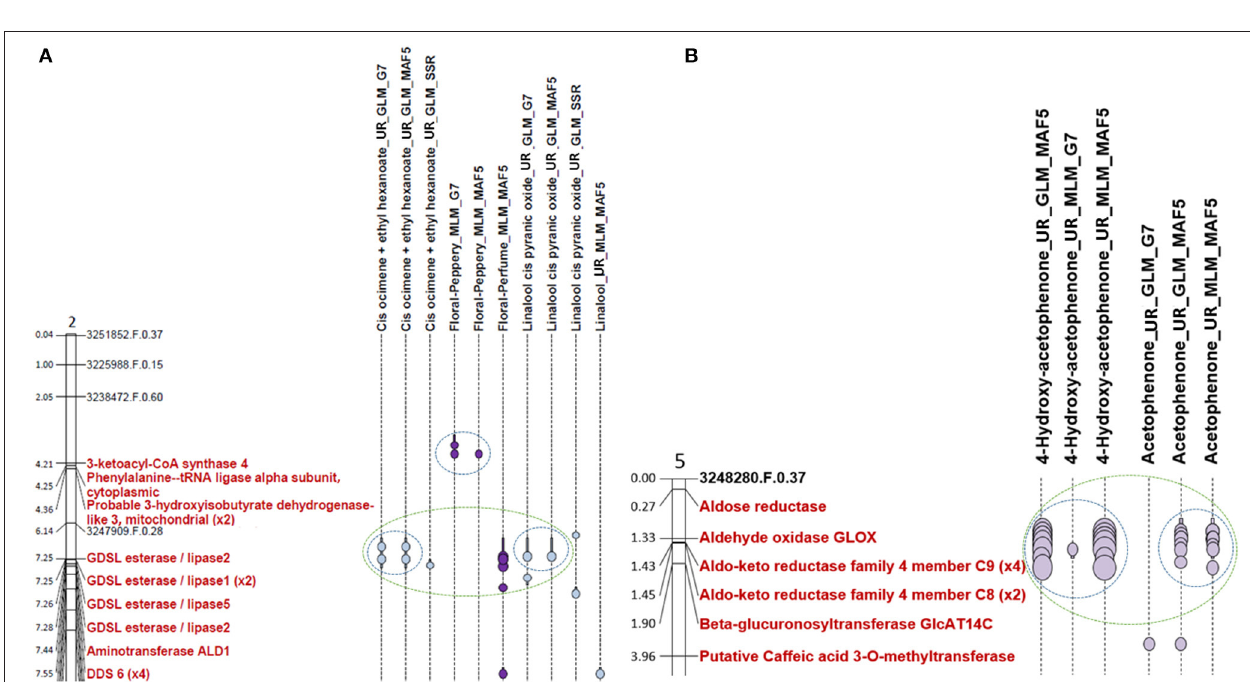
FIGURE 3 | Distribution of markers along the 10 chromosomes of T. cacao . (A) Distribution of markers from the G7 dataset along the 10 chromosomes of T. cacao . The graph shows the distribution of markers along the 10 chromosomes. The density is calculated on a 1Mb window. The areas without markers are shown in grey. The weakly marked areas are in green and the strongly marked areas are in red. A colour gradient between green and red represents the marking gradient. (B) Distribution of markers from the MAF5 dataset along the 10 chromosomes of T. cacao .